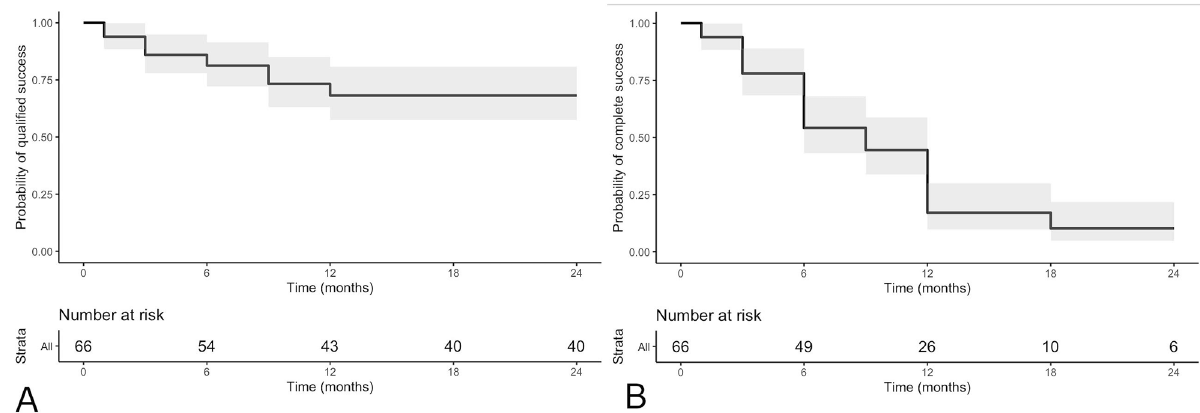
Figure 2. Kaplan–Meier survival curves of qualified success ( A ) and complete success ( B ) after ultrasound cyclo plasty. The figure was created using R (version 4.0.0) and RStudio (version 1.2.5042) software (https:// www. rstud io.